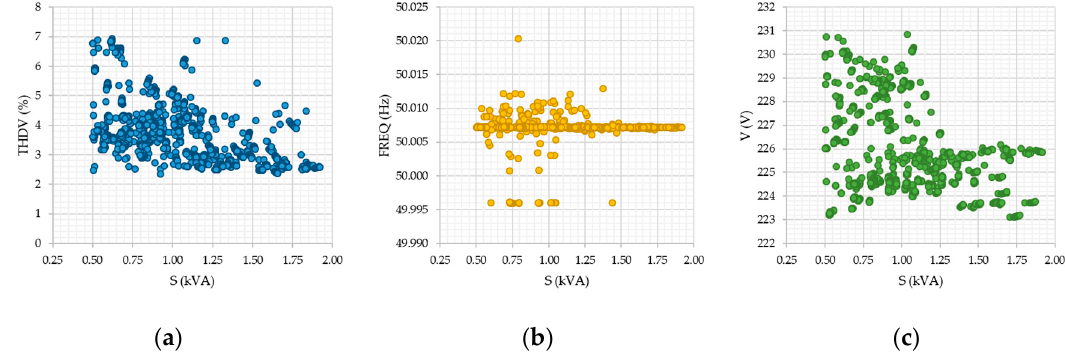
Figure 6. Pairwise relations among PQ parameters and the related load on a 50% SoC battery setup for: ( a ) voltage total harmonic distortion, ( b ) frequency, ( c ) voltage.